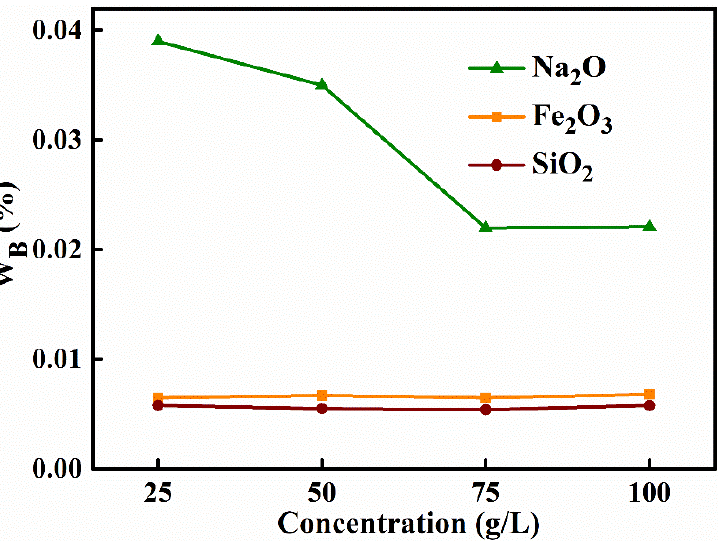
Figure 5. Effect of the mass concentration of ammonium carbonate solution on the mass fraction of the product alumina.